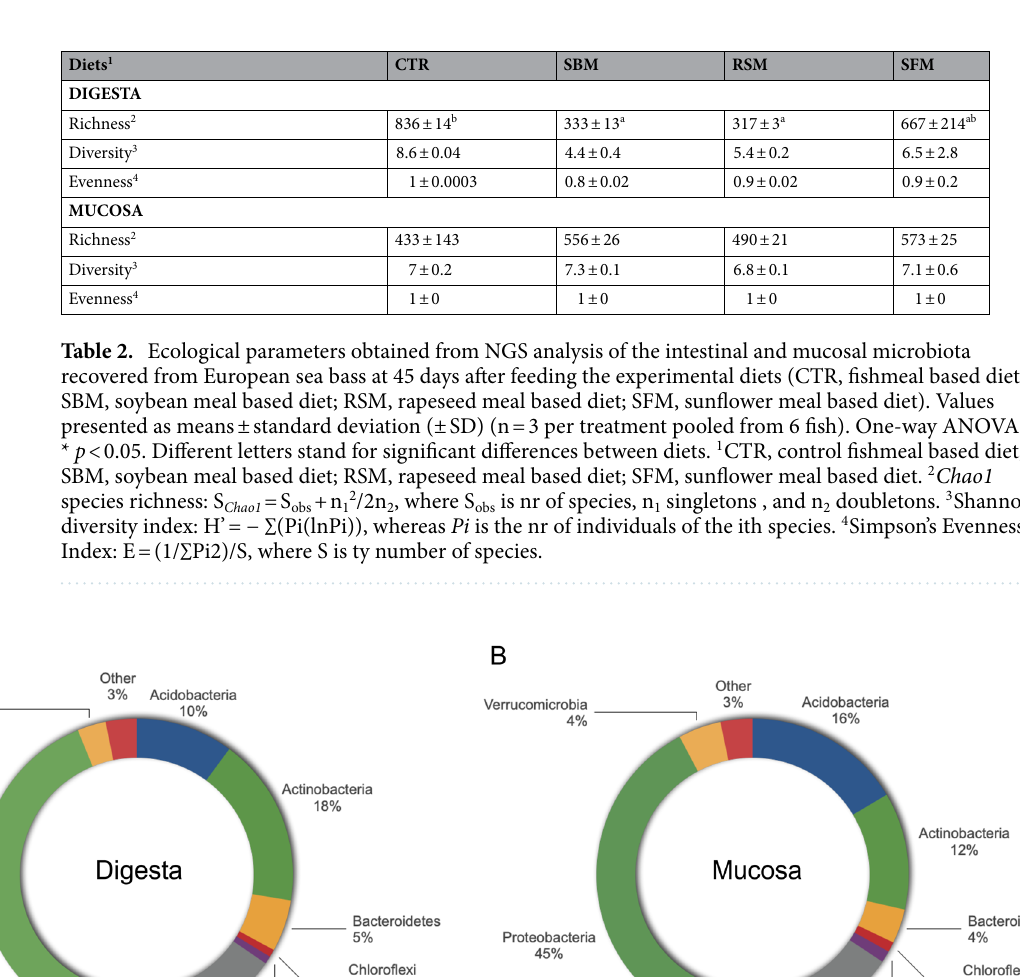
Tables S5—Digesta, and S6—Mucosa. Dietary incorporation of plant ingredients (SBM, RSM or SFM) signifi-